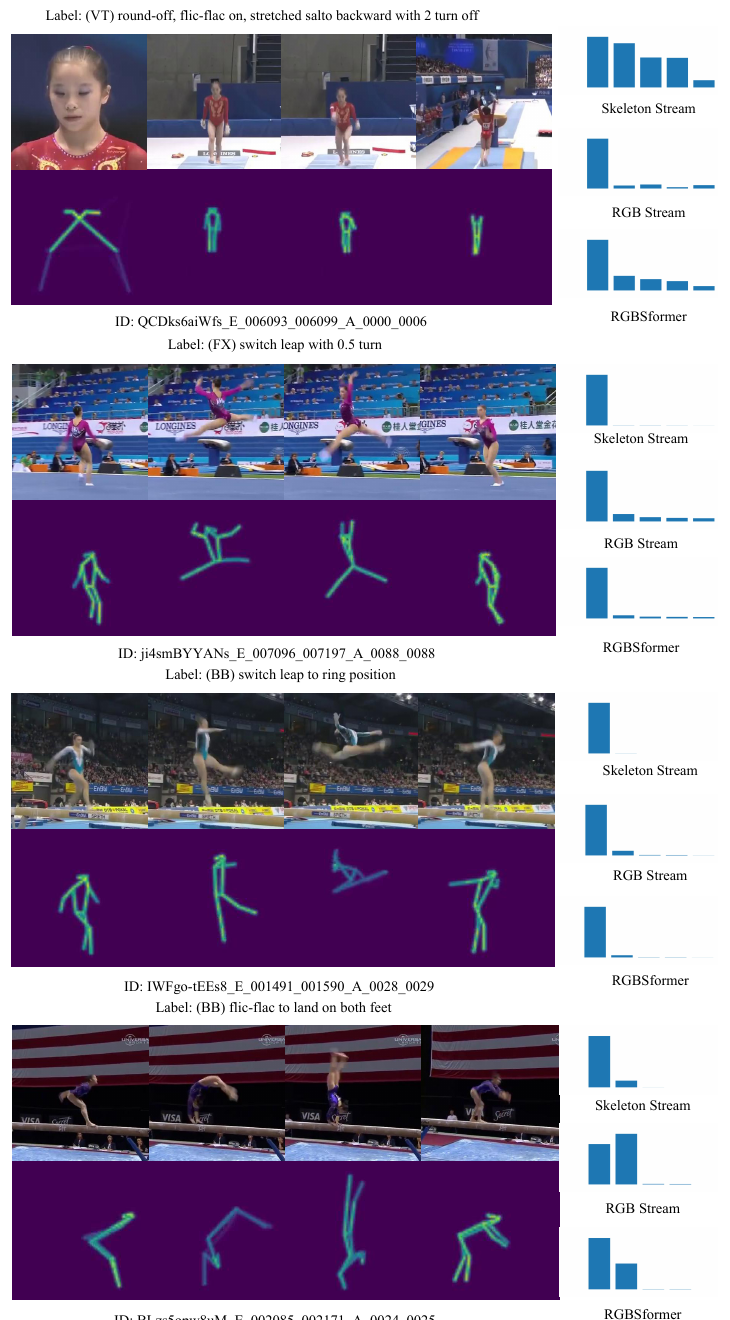
Figure 7. The examples of four videos from FineGym99 ( left ). The top five classes predicted by the skeleton stream, the RGB stream, and RGBSformer ( right